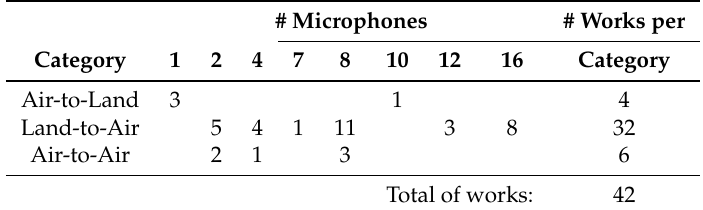
Figure 4. Distribution of works over the years analyzed in this review related to the number of microphones reported. Note that about 25% of the works reported the use of one or two microphones, likely to be associated with a sound detection objective in the auditory perception. In contrast, more complex objectives, such as classification and localization, incentivize the use four or more microphones. Table 1. Number of works with respect to the number of microphones, grouped by auditory perception category.